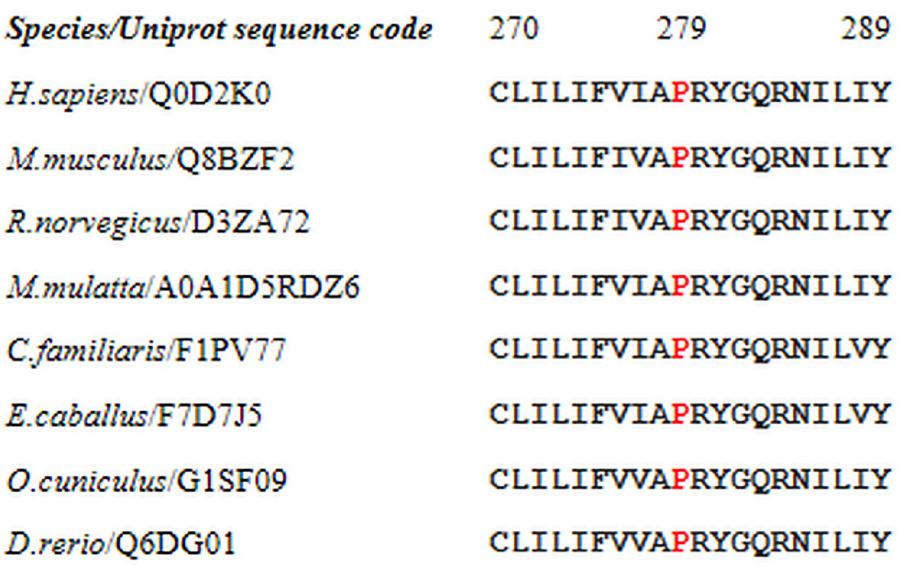
Fig 2. Multiple alignment of the NIPA4 protein sequences in different species showing the conserved nature of the proline residue at position 279 throughout species.